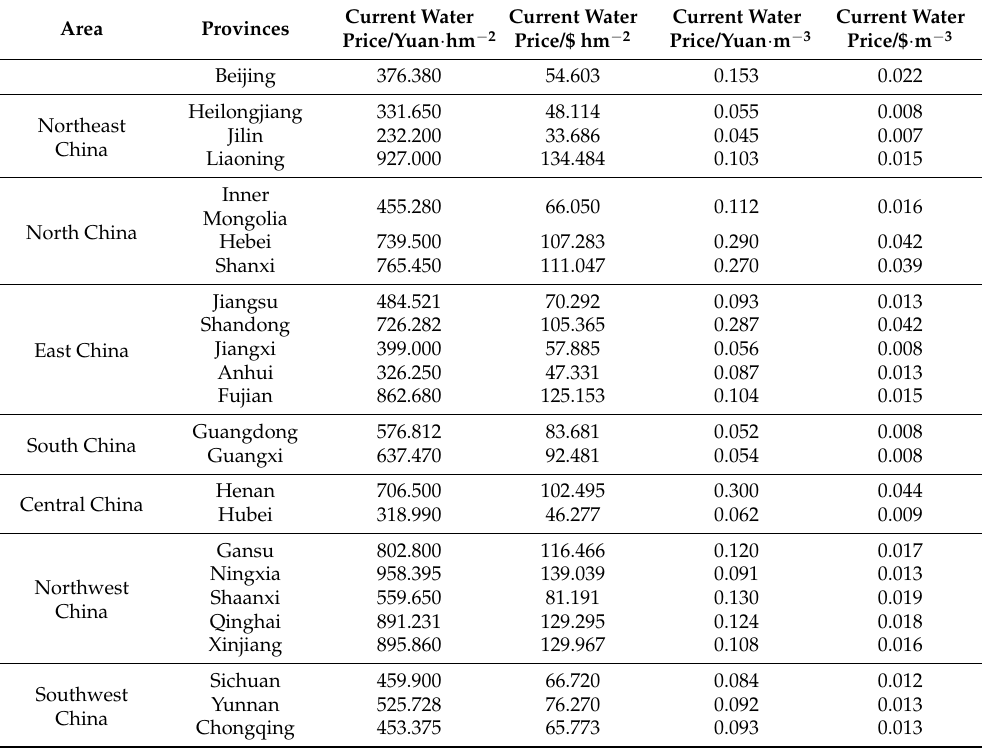
Table 12. Terminal price of agricultural